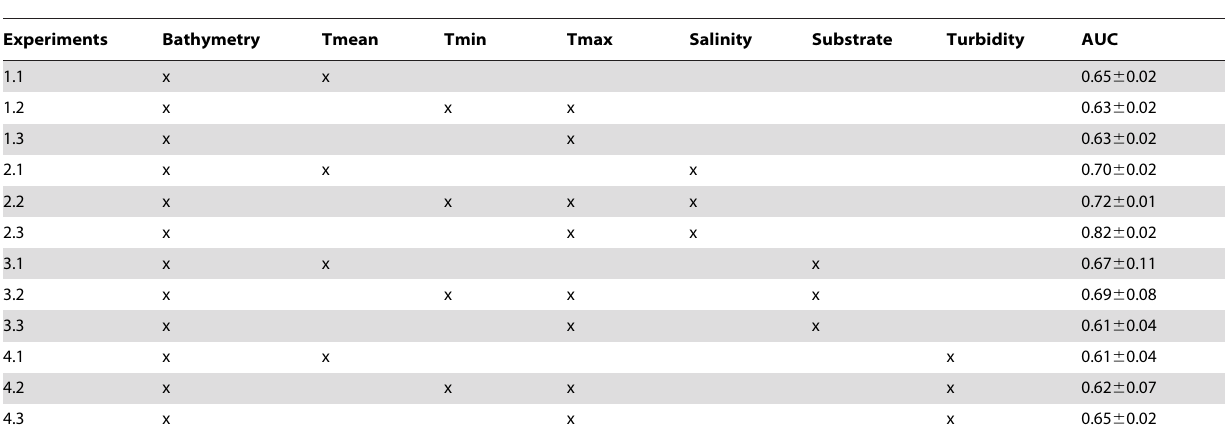
Table 1. Effects of different combinations of environmental factors on the performance of the model NPPEN applied on Laminaria